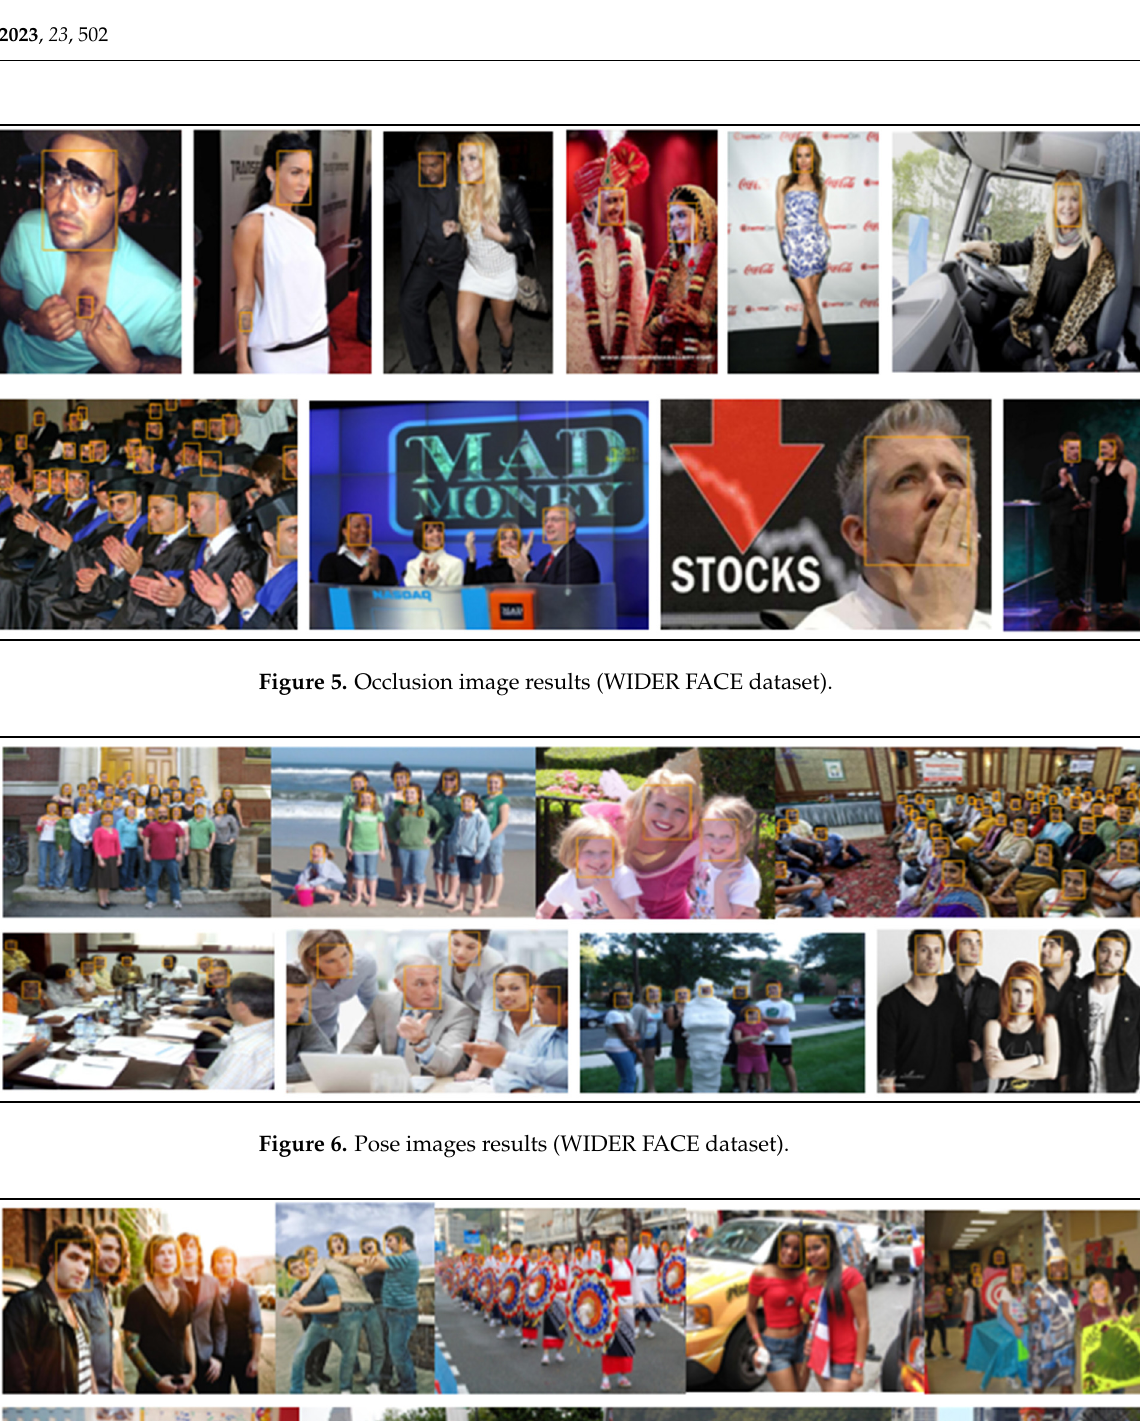
10 of 15 Figure 3. Expression image results (WIDER FACE dataset).